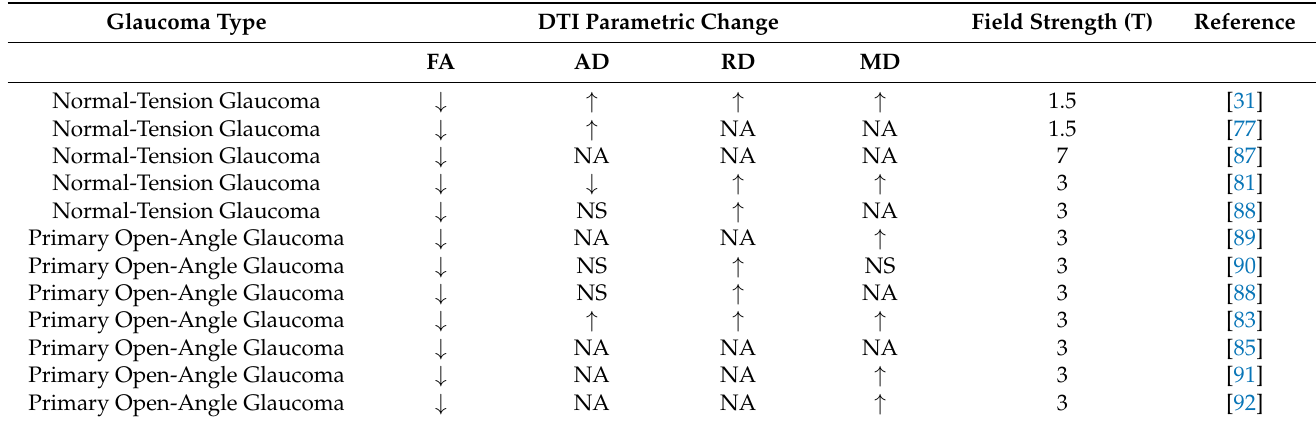
Table 2. Summary of DTI parametric changes in the optic nerve of glaucoma patients relative to healthy controls in selected articles.